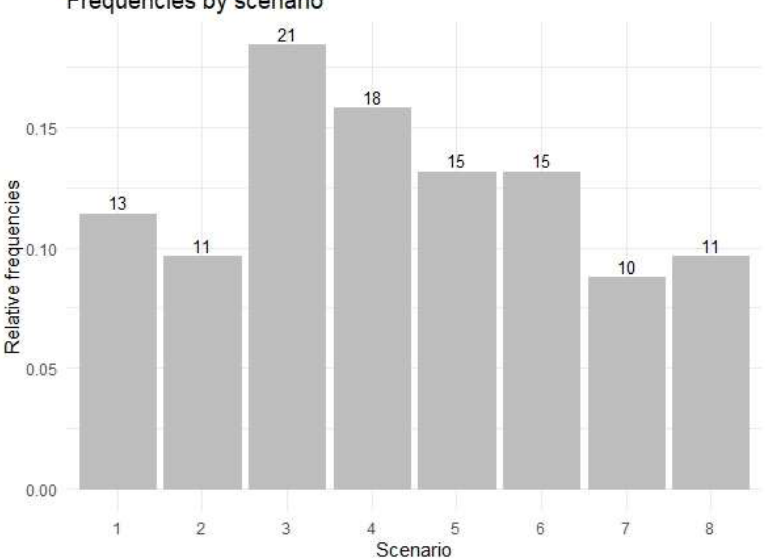
Figure 1. Bar graph of the different scenarios on the same case of pulp abscess in